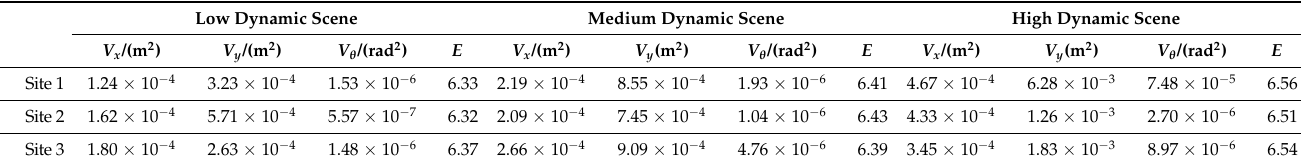
Table 1. The results of the V i and E of multiple localization results in different dynamic environments.